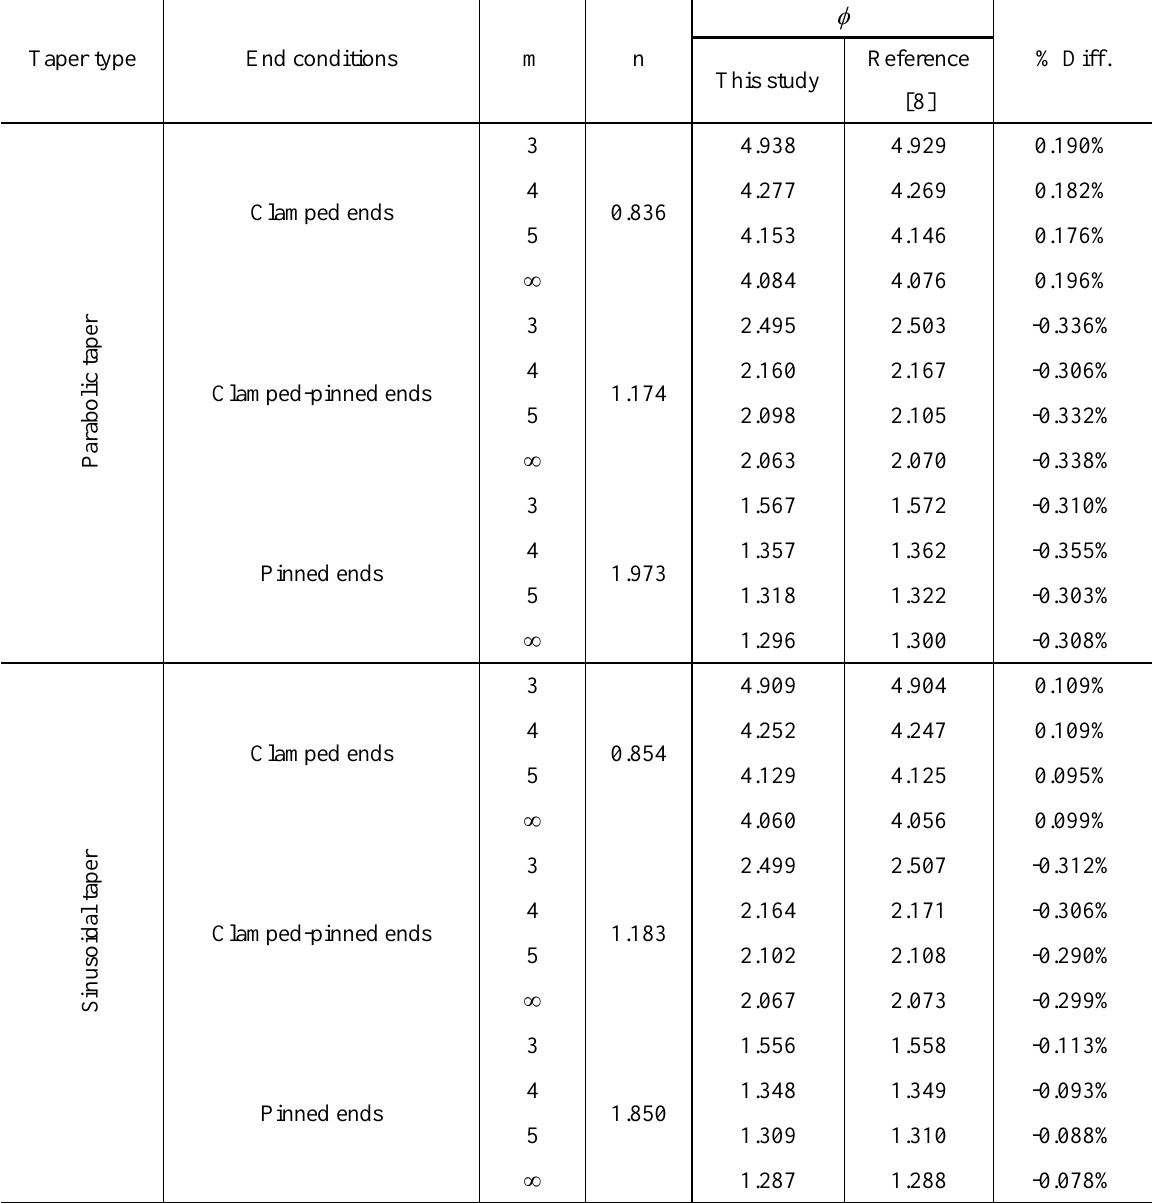
Table 2 Comparison of buckling load parameter results between this study and reference [8]. Taper